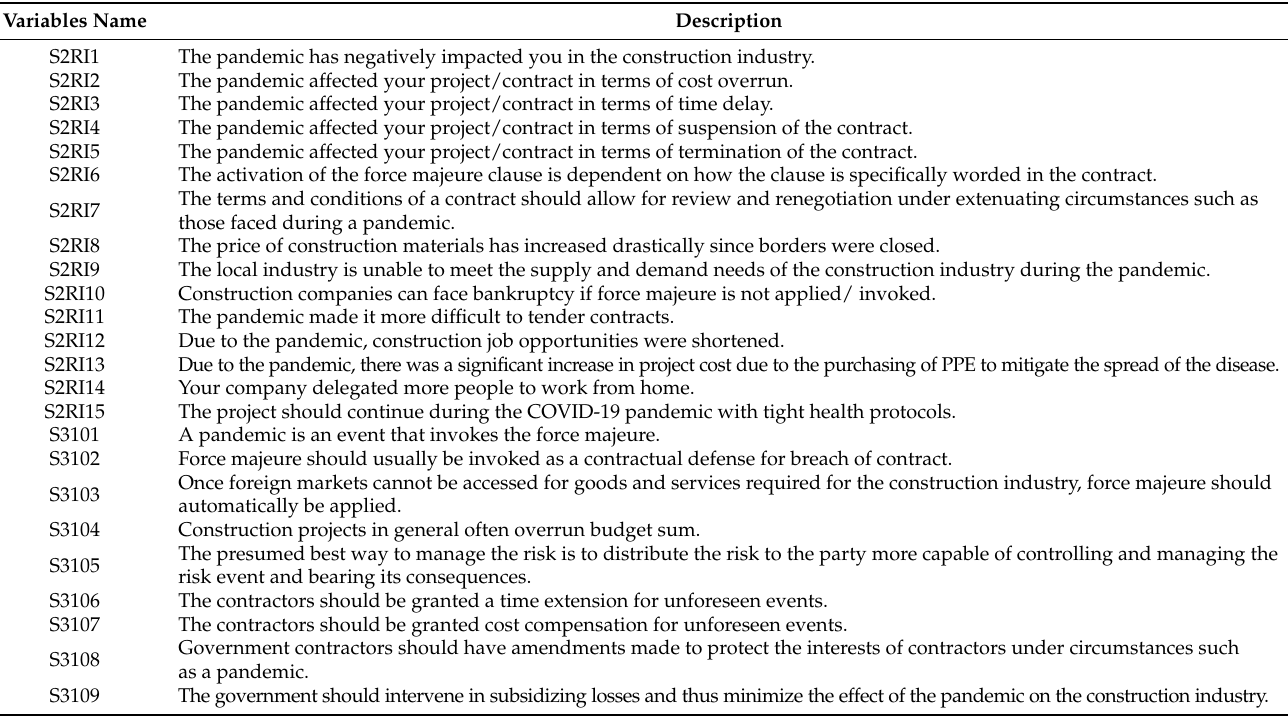
Table 4. Showing the variables from the questionnaire and SPSS